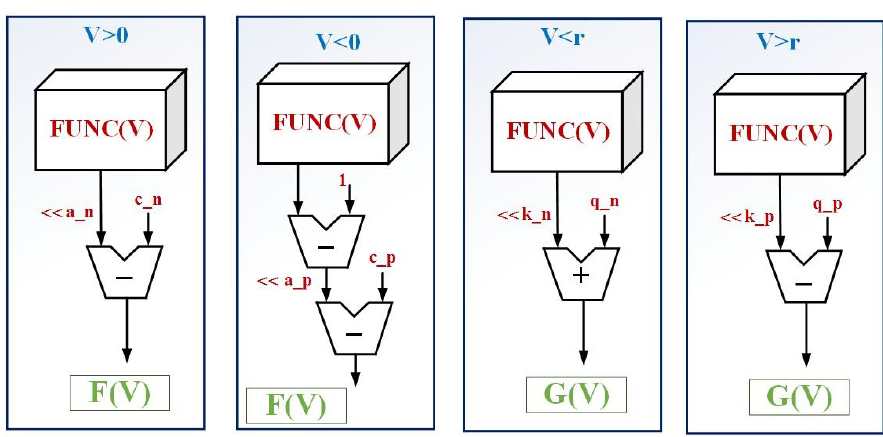
Figure 8. Realization of the proposed F ( V ) and G ( V ) functions.